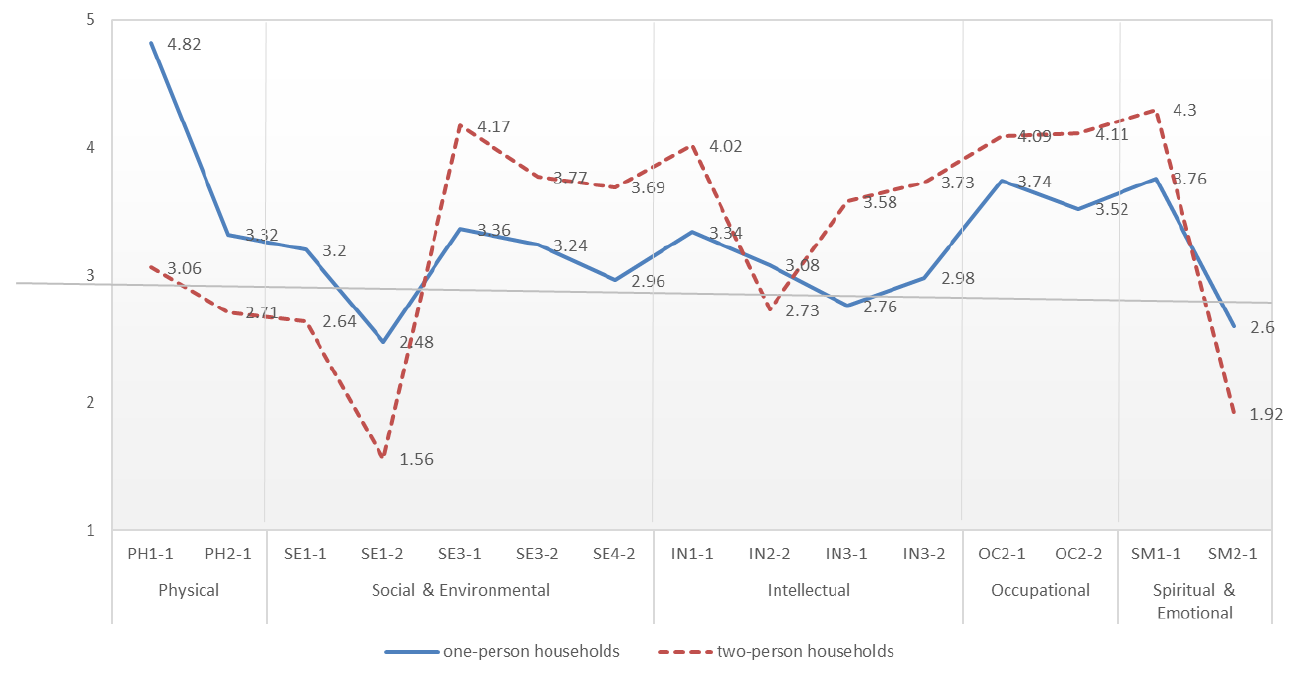
Figure 2. Comparison of Wellness Between One-person and Two-person Households.